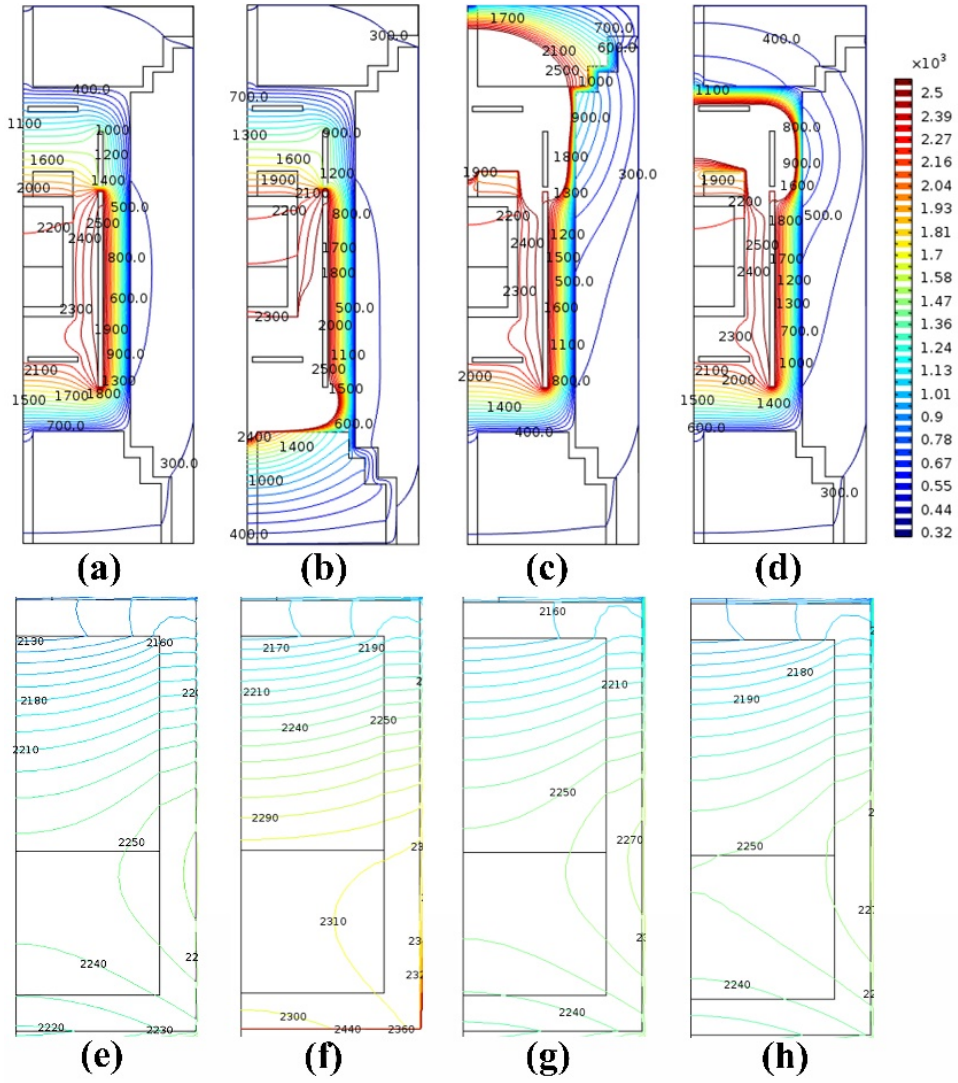
Figure 2. The distribution of temperature in the growth chamber and inside the crucible with different heating modes: ( a , e ) side heating 1 mode, ( b , f ) side 1 heater + bottom heater mode, ( c , g ) side 1 heater + top heater mode, and ( d , h ) side 1 heater + side 2 heater